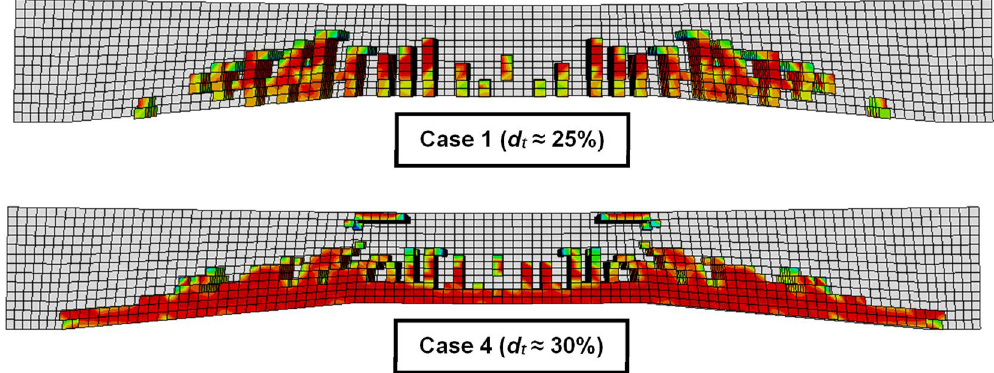
Figure 6. Samples of damage calculation models in two deterministic